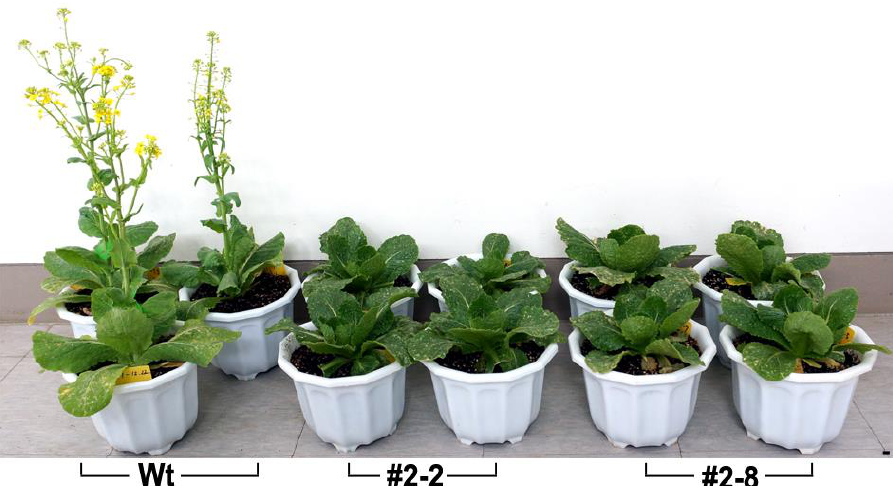
Figure 4. Flowering-time phenotype in ‘transgene - free’ BrVRN1 GE2 mutant lines. Pictures were taken 31 days at 25 °C after a 40-day exposure to 4 °C. Wt, untransformed wild-type plants; #2-2 and #2-8 , selected ‘transgene - free’ GE2 mutant lines, respectively.